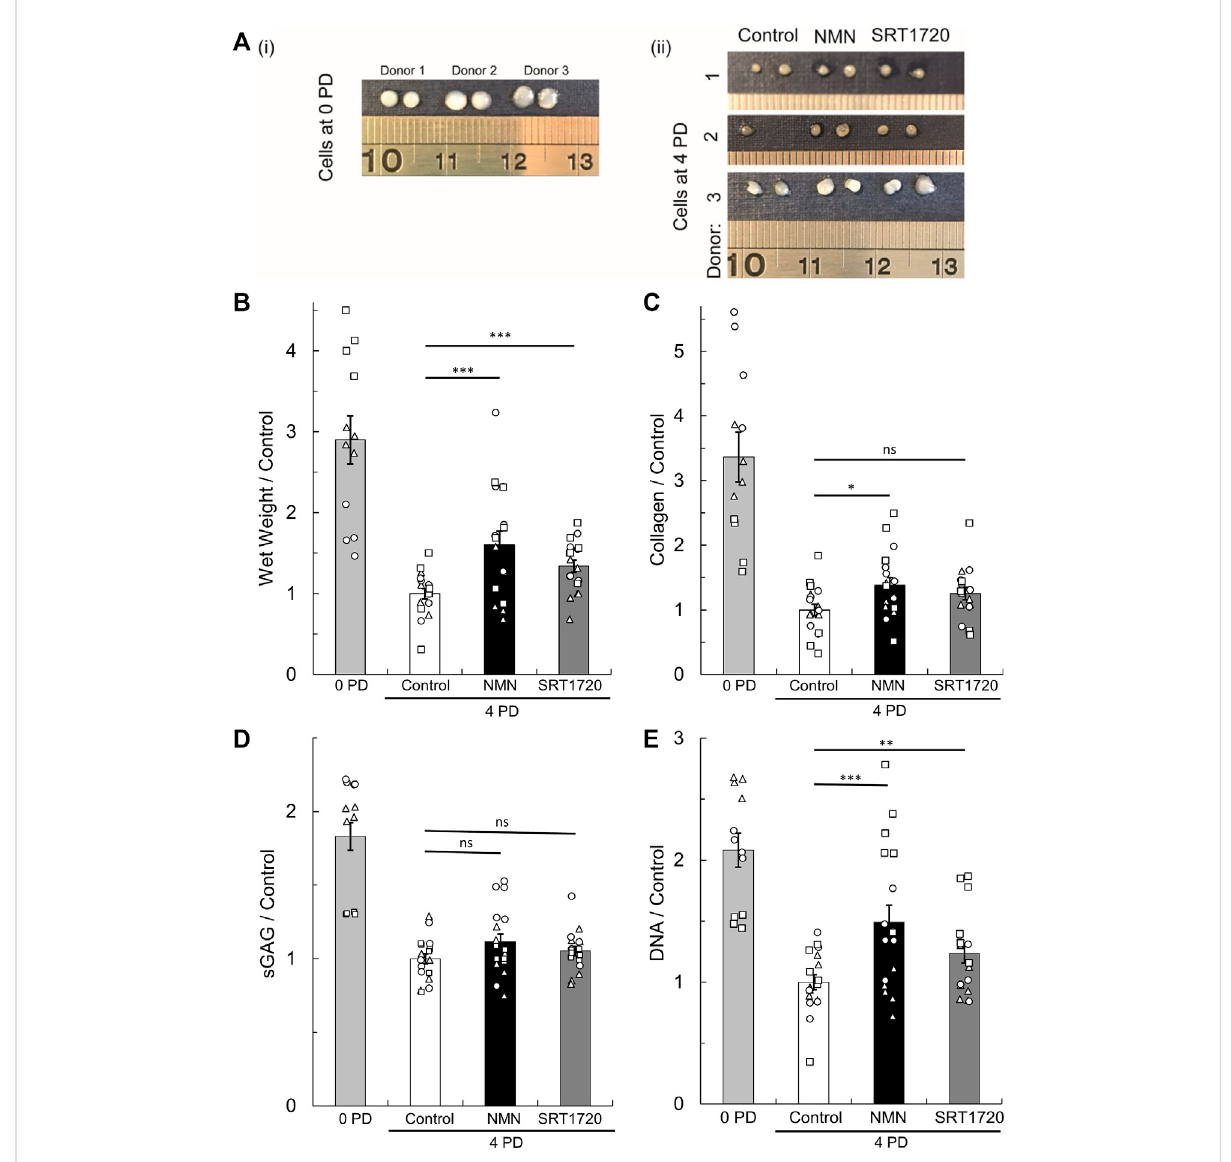
FIGURE 6 Regenerationofcartilagetissuefollowingtransferofmonolayercellsto3Dpelletculture. (A) Representativetissuemassesformedafter21 days cultureofcellpelletscreatedfrom(i)freshlyisolatedcells(0PD)or(ii)monolayerexpandedforfourpopulationdoublings(4PDs)inmediacontaining 10 mM glucose supplemented with the pan-sirtuin activator, 100 µM NMN, or the SIRT1 speci fi c activator, 100 nM SRT1720, or untreated controls. Scale units cm. (B) Pellet wet weight, (C) collagen content, (D) sulphated glycosaminoglycan (sGAG) content, and (E) DNA content at day 21relativetothe4PDcontrol.Mean±s.e.m, n 0PD =12, n 4PD =18fromthreedonorsindicatedbysymbolshape.2-factorANOVAwithreplicationand bonferroni correction: * p < 0.05, ** p < 0.01 *** p < 0.001, ns p > 0.05. The cell number seeded to pellets for each treatment group is shown in Supplementary Figure